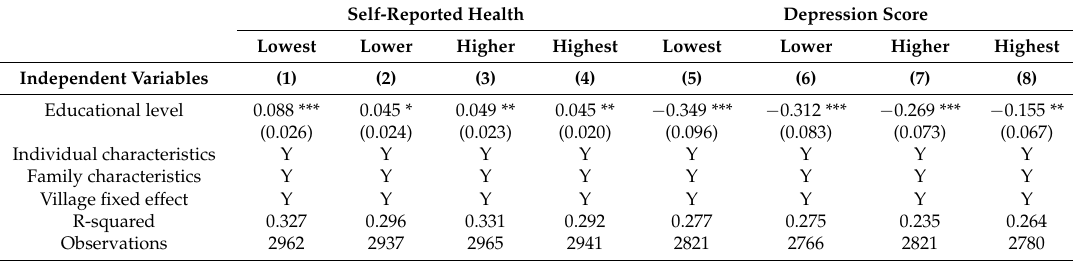
Table 6. The impact of education on health by age cohorts, by per capita net income of